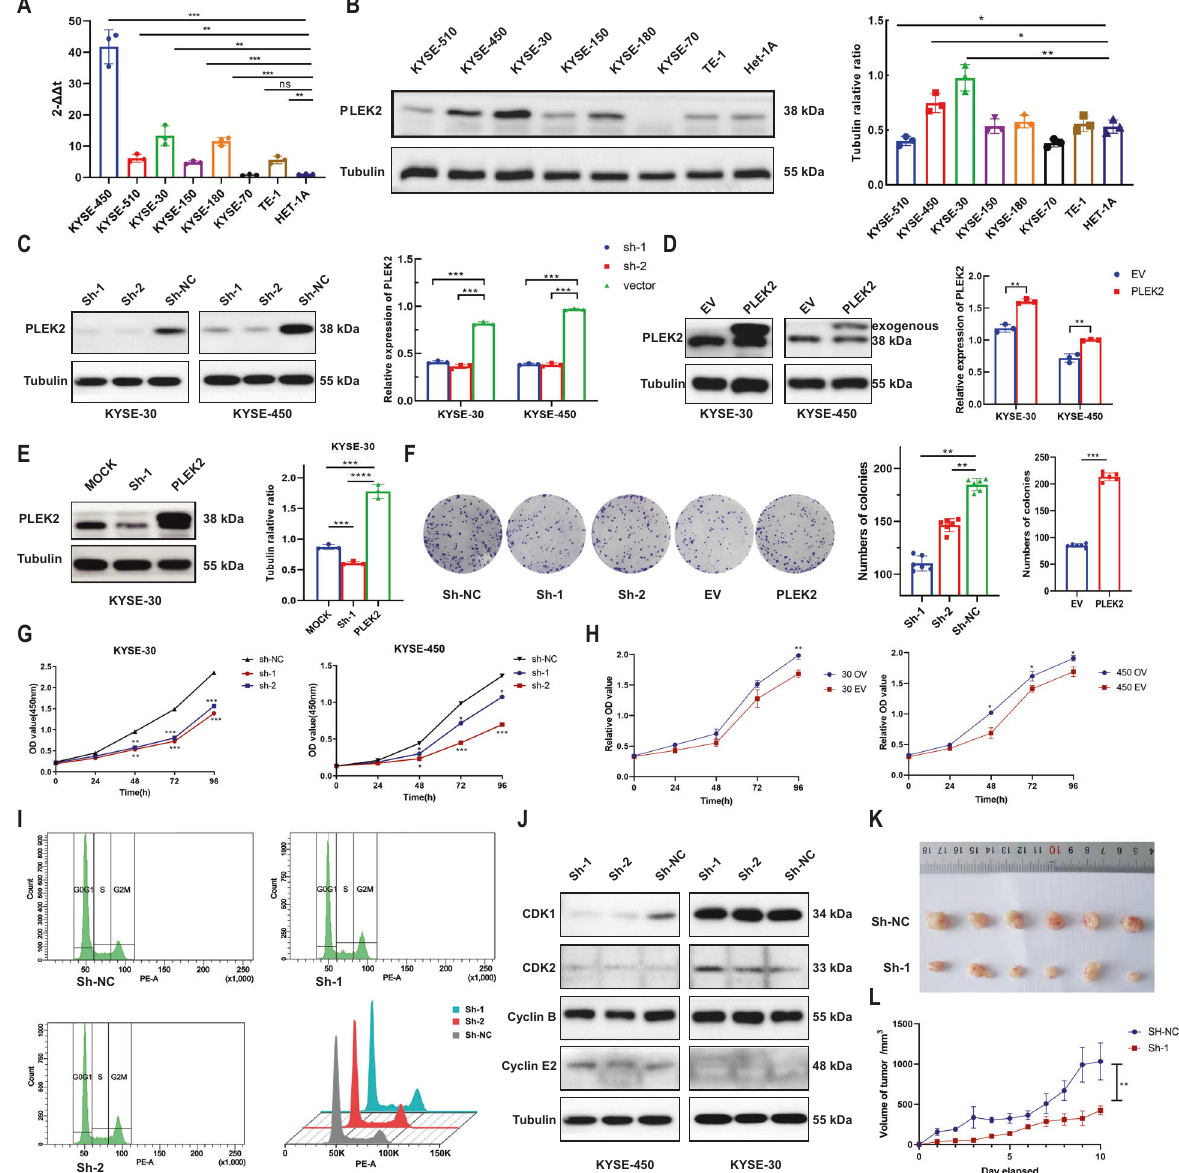
Fig. 2 Silence of PLEK2 inhibited proliferation of ESCC cells in vivo and vitro. A Expression of PLEK2 in ESCC cell lines detected by qPCR; B Western blot analysis of level of PLEK2 in several ESCC cell lines; C Silence of PLEK2 expression in KYSE-30 and KYSE-450. Western Blot was used to con fi rm the knockdown ef fi ciency; D Overexpression of PLEK2 expression in KYSE-30 and KYSE-450 Western Blot was used to con fi rm the overexpression ef fi ciency; E Reverse effect of PLEK2 overexpression plasmid on PLEK2 stably knockdown KYSE-30 and KYSE-450; F The colony generated by KYSE-30 with or without PLEK2 stably knockdown, as well as KYSE-30 with or without PLEK2 stably overexpressed. G Proliferation ability of stably knockdown PLEK2 in KYSE-30 and KYSE-450 detected by CCK-8 assay; H Proliferation ability of stably overexpression PLEK2 in KYSE-30 and KYSE-450 detected by CCK-8 assay; I Flow cytometry diagrams of cell cycle of both KYSE-30 with or without PLEK2 stably knockdown. J Western blot analysis for the expression of CDK1, CDK2, Cyclin B, and Cyclin E2, which related to cell cycle. Tubulin was used as loading control; K Representative xenograft tumours derived from mice subcutaneously injected with KYSE-30 cells with or without PLEK2 stably knockdown. ( n = 6 in each group). L The growth curve of tumours in two groups ( n = 6 in each group). * P < 0.01; *** P < 0.01; *** P < 0.001. the up-regulated genes in KYSE-30 and KYSE-180 cell lines with 2 mg/kg, 4 mg/kg, and 8 mg/kg cisplatin. Results of IHC conducted average log 2FC at 3.12 and 1.7 respectively (Supplementary Fig. on tumour tissues indicated that the expression of PLEK2 was S3). PLEK2 knockdown cells showed lower migration capability gradually increased as the dosage increased (Fig. 4H). when treated with TGF- β (Fig. 5A). TGF- β is associated with the expression of PLEK2, and with continuous stimulation by TGF- β at TGF- β induces PLEK2 expression and its potential function in the concentration of 10 μ M, the level of PLEK2 was upregulated phenotypic alteration over time (Fig. 5B). The level of PLEK2 Claudin-1 was upregulated Our laboratory has conducted RNA-seq experiment on ESCC cell on protein level, especially in KYSE-30 cells. The stimulation of lines which were treated by TGF- β . PLEK2 was found to be among Cell Death and Disease (2021)